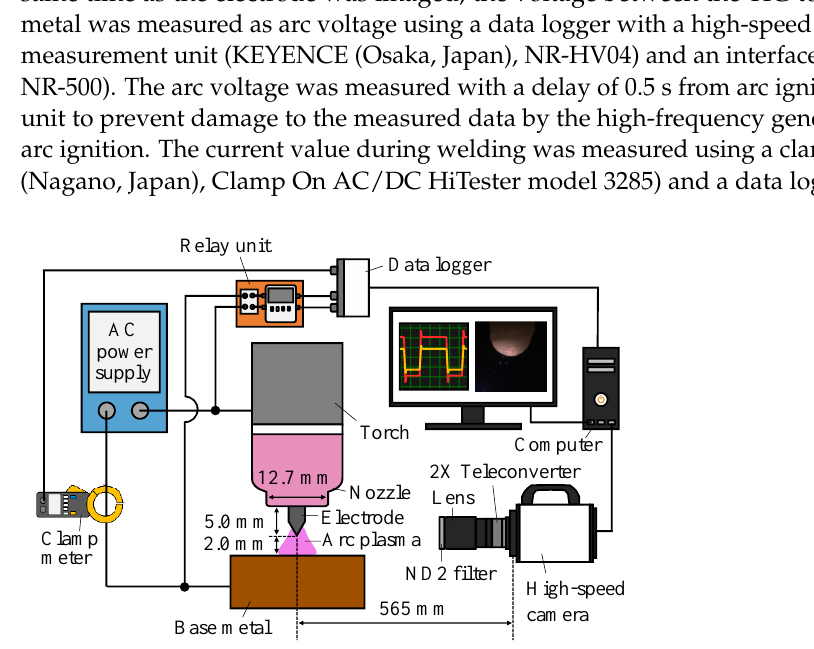
Figure 1. Schematic illustration of the experimental setup used to observe the electrode’s appearance.